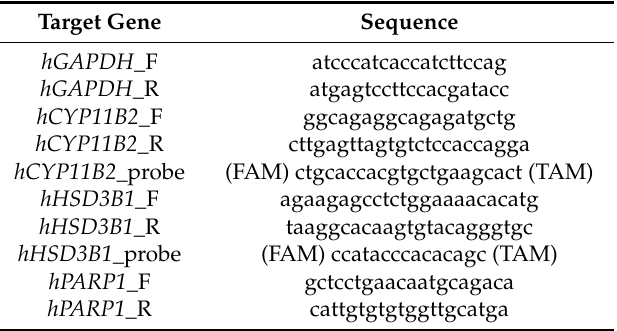
Table 1. Primer and TaqMan probe sequences for quantitative real time polymerase chain reaction